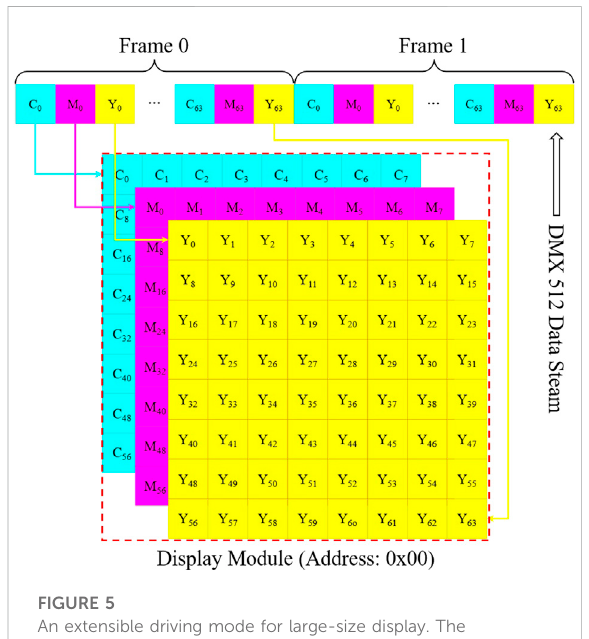
FIGURE 5 An extensible driving mode for large-size display. The mapping relationship between pixel points and DMX data streams. It shows the mapping relationship between grayscale data of colorful display panels and data